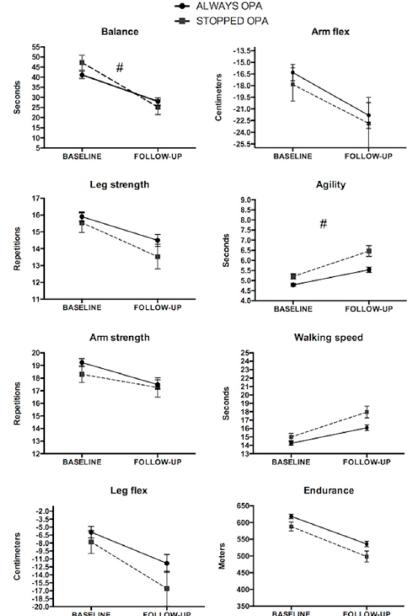
Figure 1. Fitness changes according to organized physical activity (OPA) engagement during the follow-up in males. # Significant group-by-time interaction. Both groups showed a significant decrease from baseline to follow-up ( p < 0.05), except for the arm strength of the group that stopped OPA ( p = 0.100).